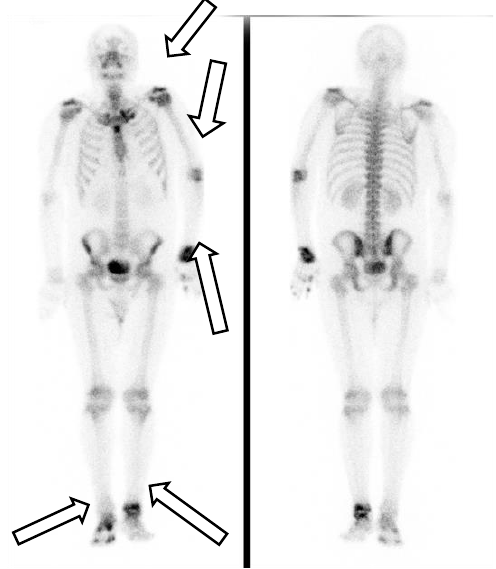
Figure 1. A technetium-99m methylene diphosphonate bone scan revealed increased uptake in the left shoulder, elbow, wrist, and ankle, and right foot and toes.